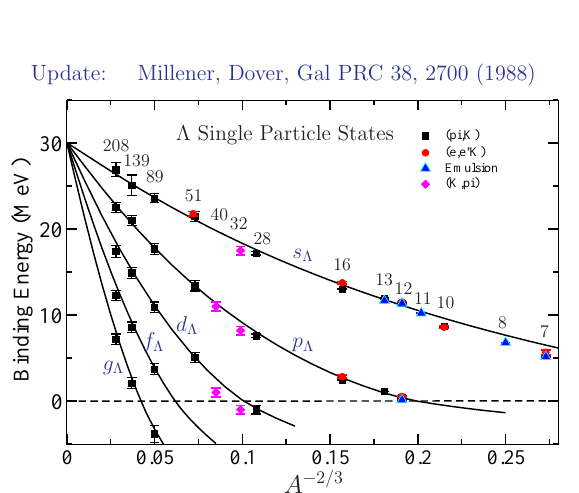
Figure 1. Compilation of Λ binding energies in 7 Λ Li to 208 Λ Pb from various sources, and as calculated using a three-parameter WS potential [2]. Figure adapted from Ref.